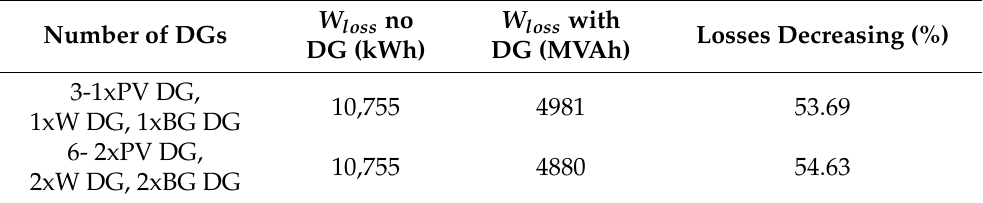
Table 15. Decreasing the yearly power losses by optimal allocation and power management of DGs in the IEEE 37 Node Test